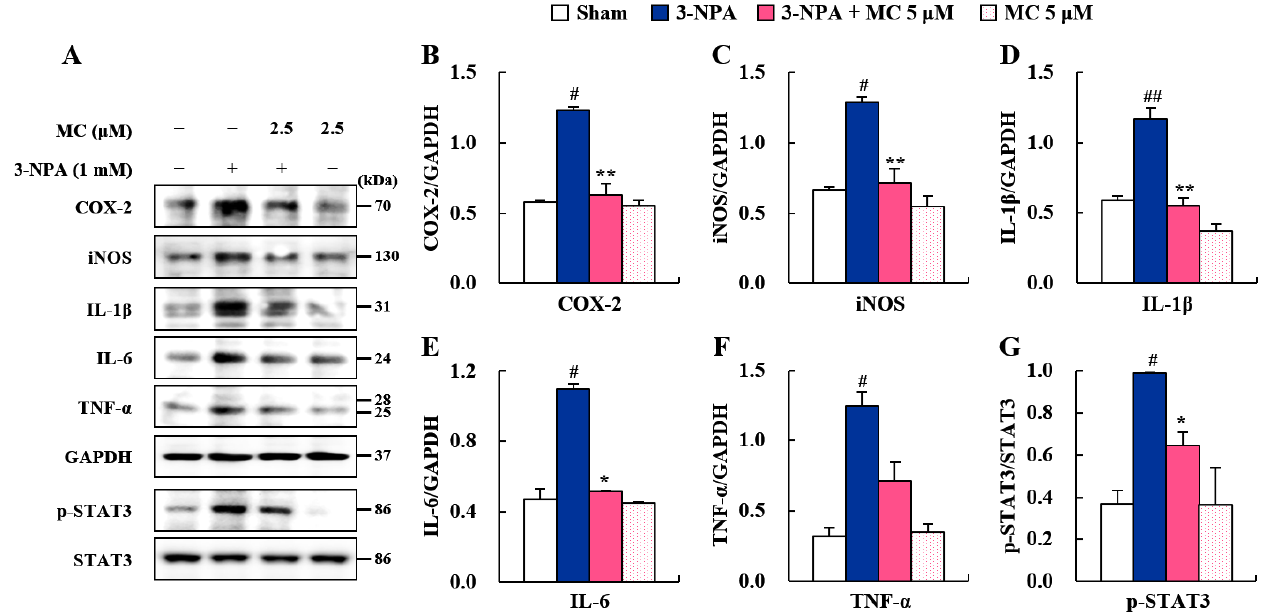
Figure 5. MC reduces the expression of inflammatory factors and p-STAT3 in 3-NPA-induced BV2 cells. ( A – G ) Cultured BV2 cells were treated with MC (5 µ M) at 1 h before stimulation with 3-nitropropionic acid (3-NPA) (1.0 mM). Culture medium was replaced with fresh medium and incubated for 12 h. BV2 cells from sham, 3-NPA, 3-NPA + MC (5 µ M), and MC (5 µ M) groups were used for Western blot analysis to determine protein expression levels of representative inflammatory enzymes (COX-2 ( A , B ) and iNOS ( A , C )), cytokines (IL-1 β ( A , D ), IL-6 (A and E), and TNF- α ( A , F )), and p-STAT3 ( A , G ). MC alleviated their expression levels ( A – G ). Assays were repeated at least three times, with each experiment performed in triplicate. Data are expressed as mean ± standard error of the mean (Kruskal–Wallis; # p < 0.05 and ## p < 0.01 versus sham group; * p < 0.05 and ** p < 0.01 versus 3-NPA group).